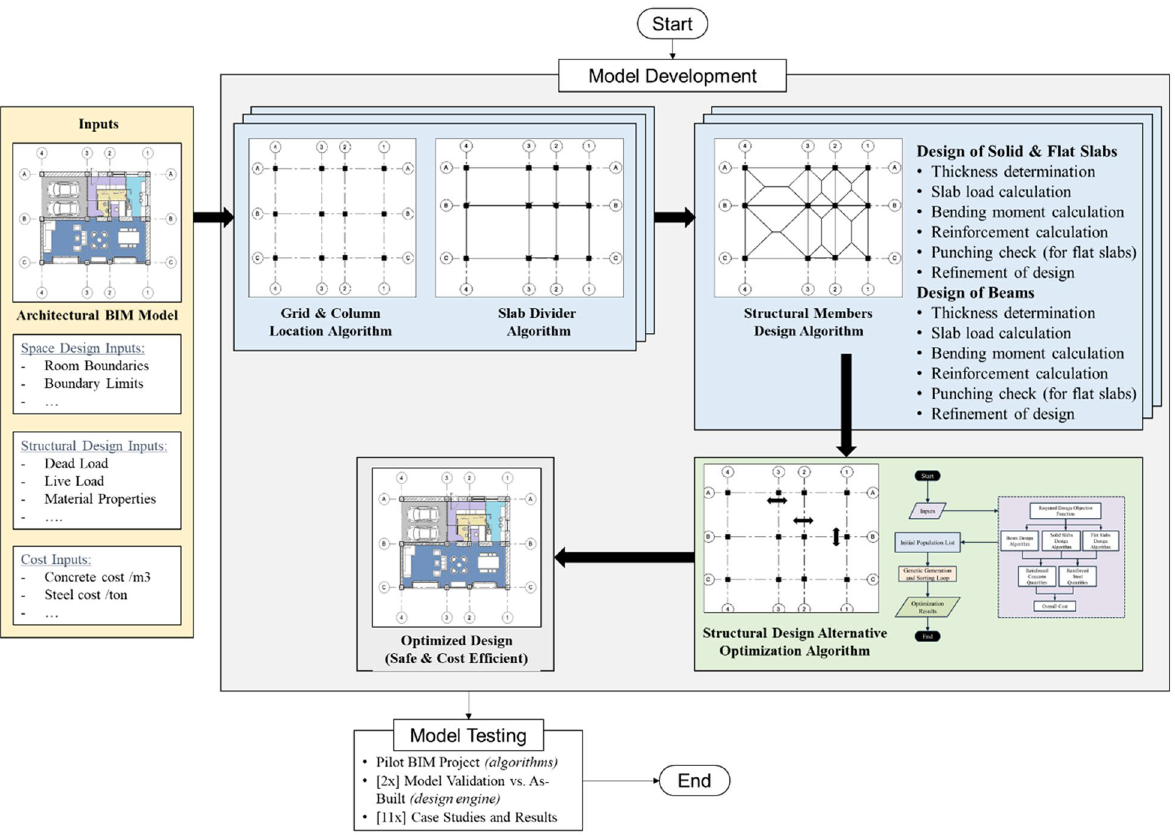
Figure 1. Research methodology.